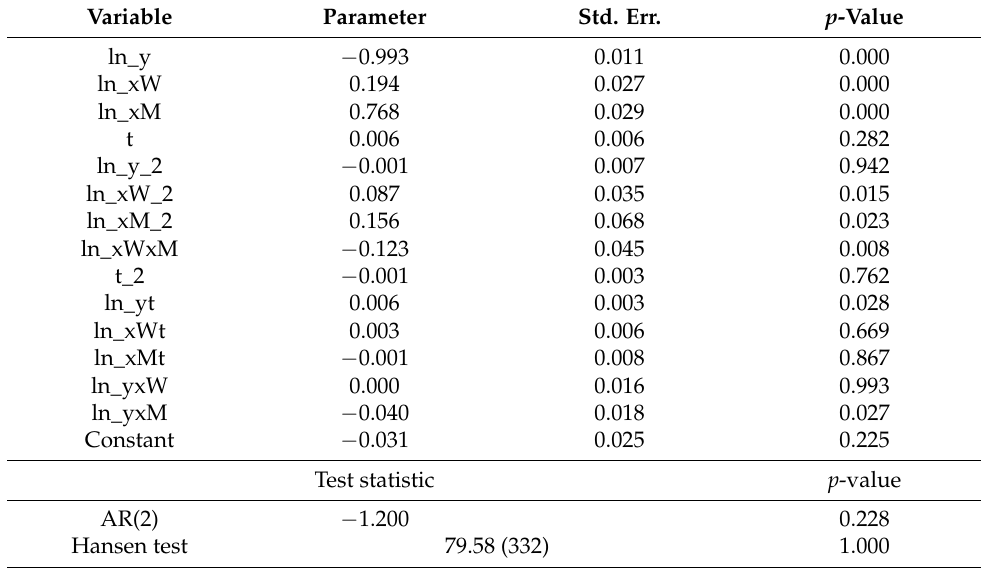
Table A2. IDF—tomato processing. Source: authors’ estimates.